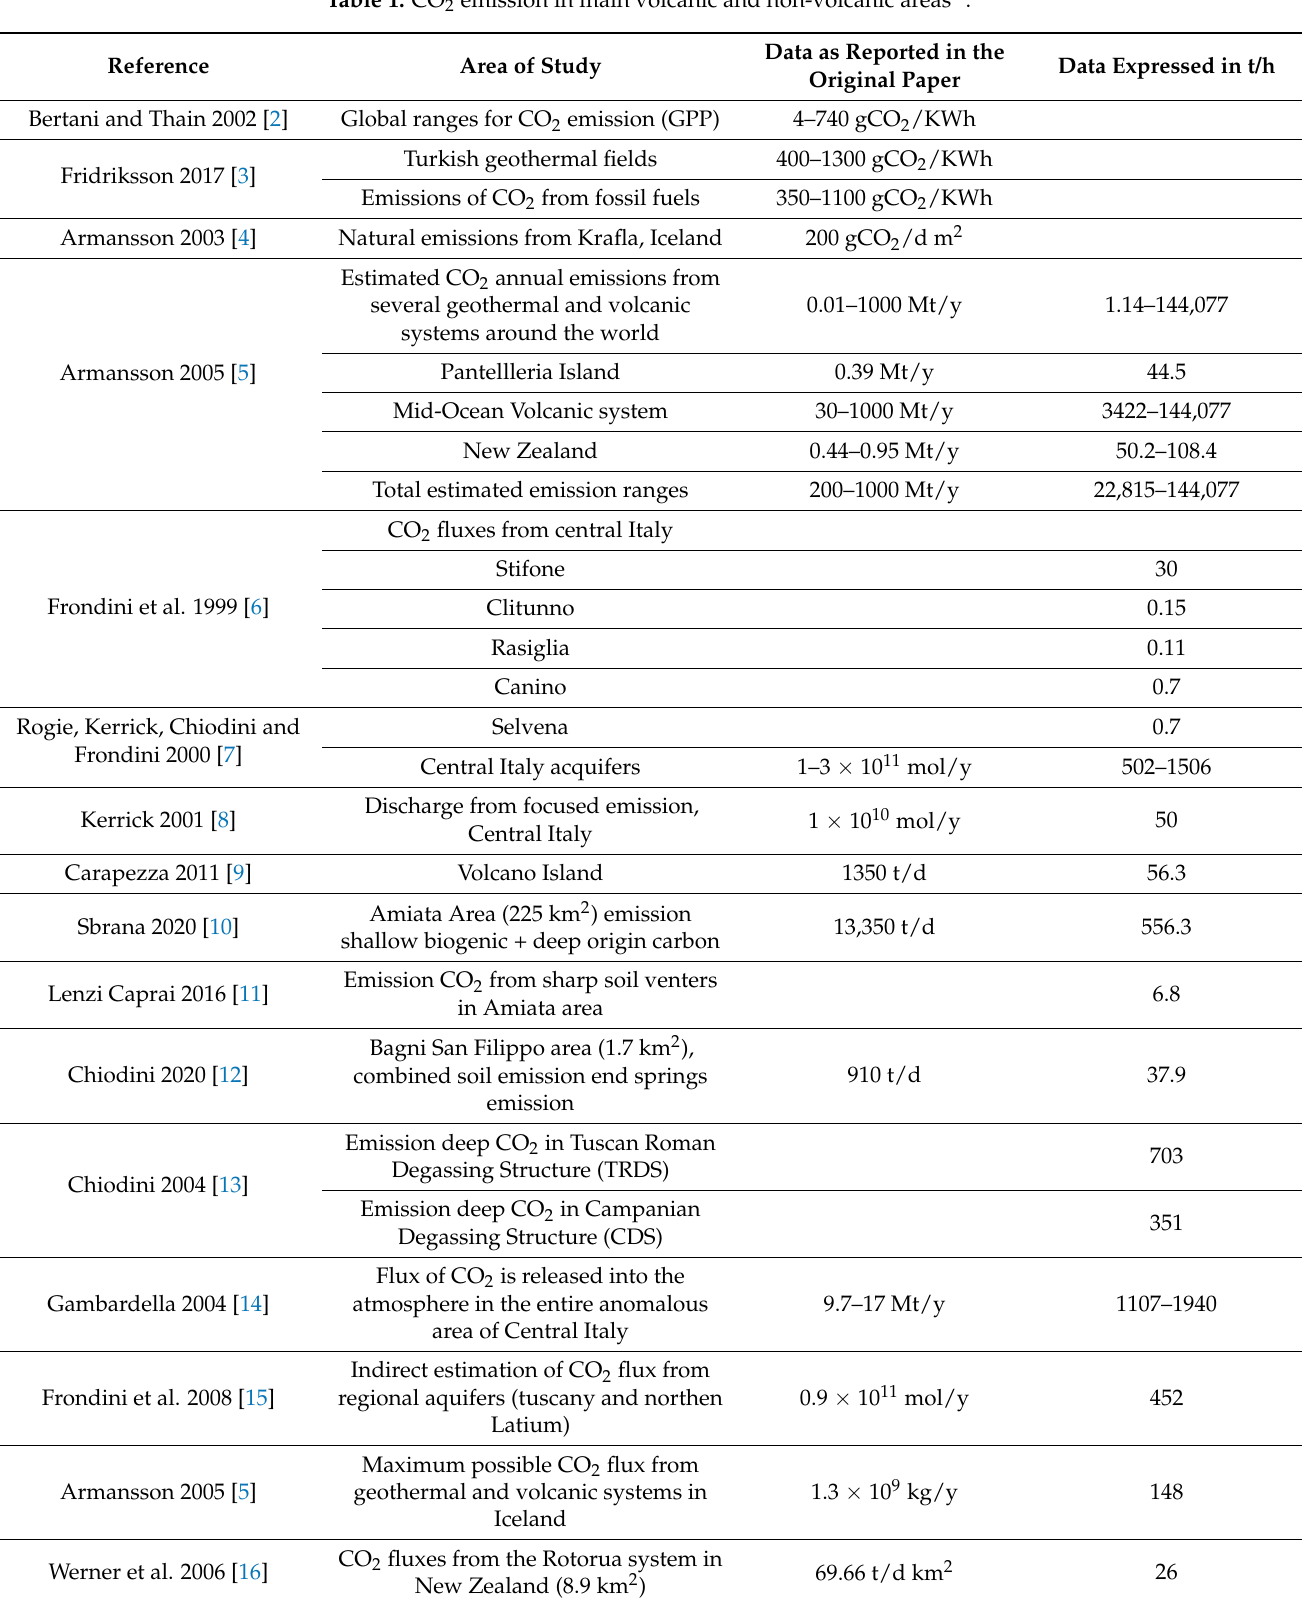
Table 1. CO 2 emission in main volcanic and non-volcanic areas